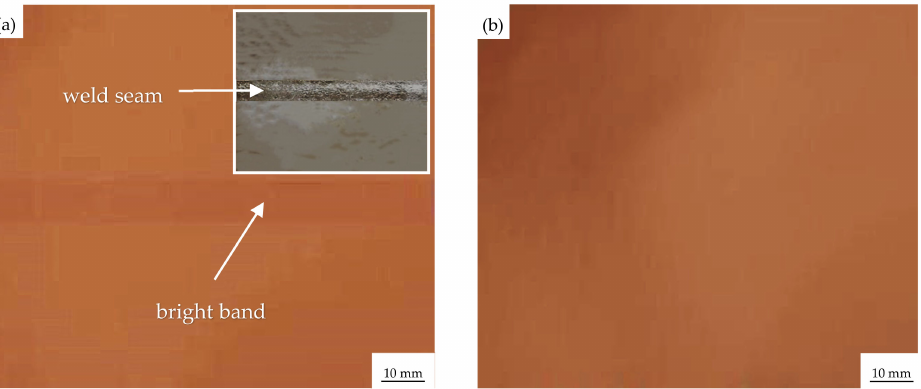
Figure 8. Morphology of electrolytic copper foil by welded TA1 titanium cathode roller ( a ) Without the novel complex treatment; ( b ) With the novel complex